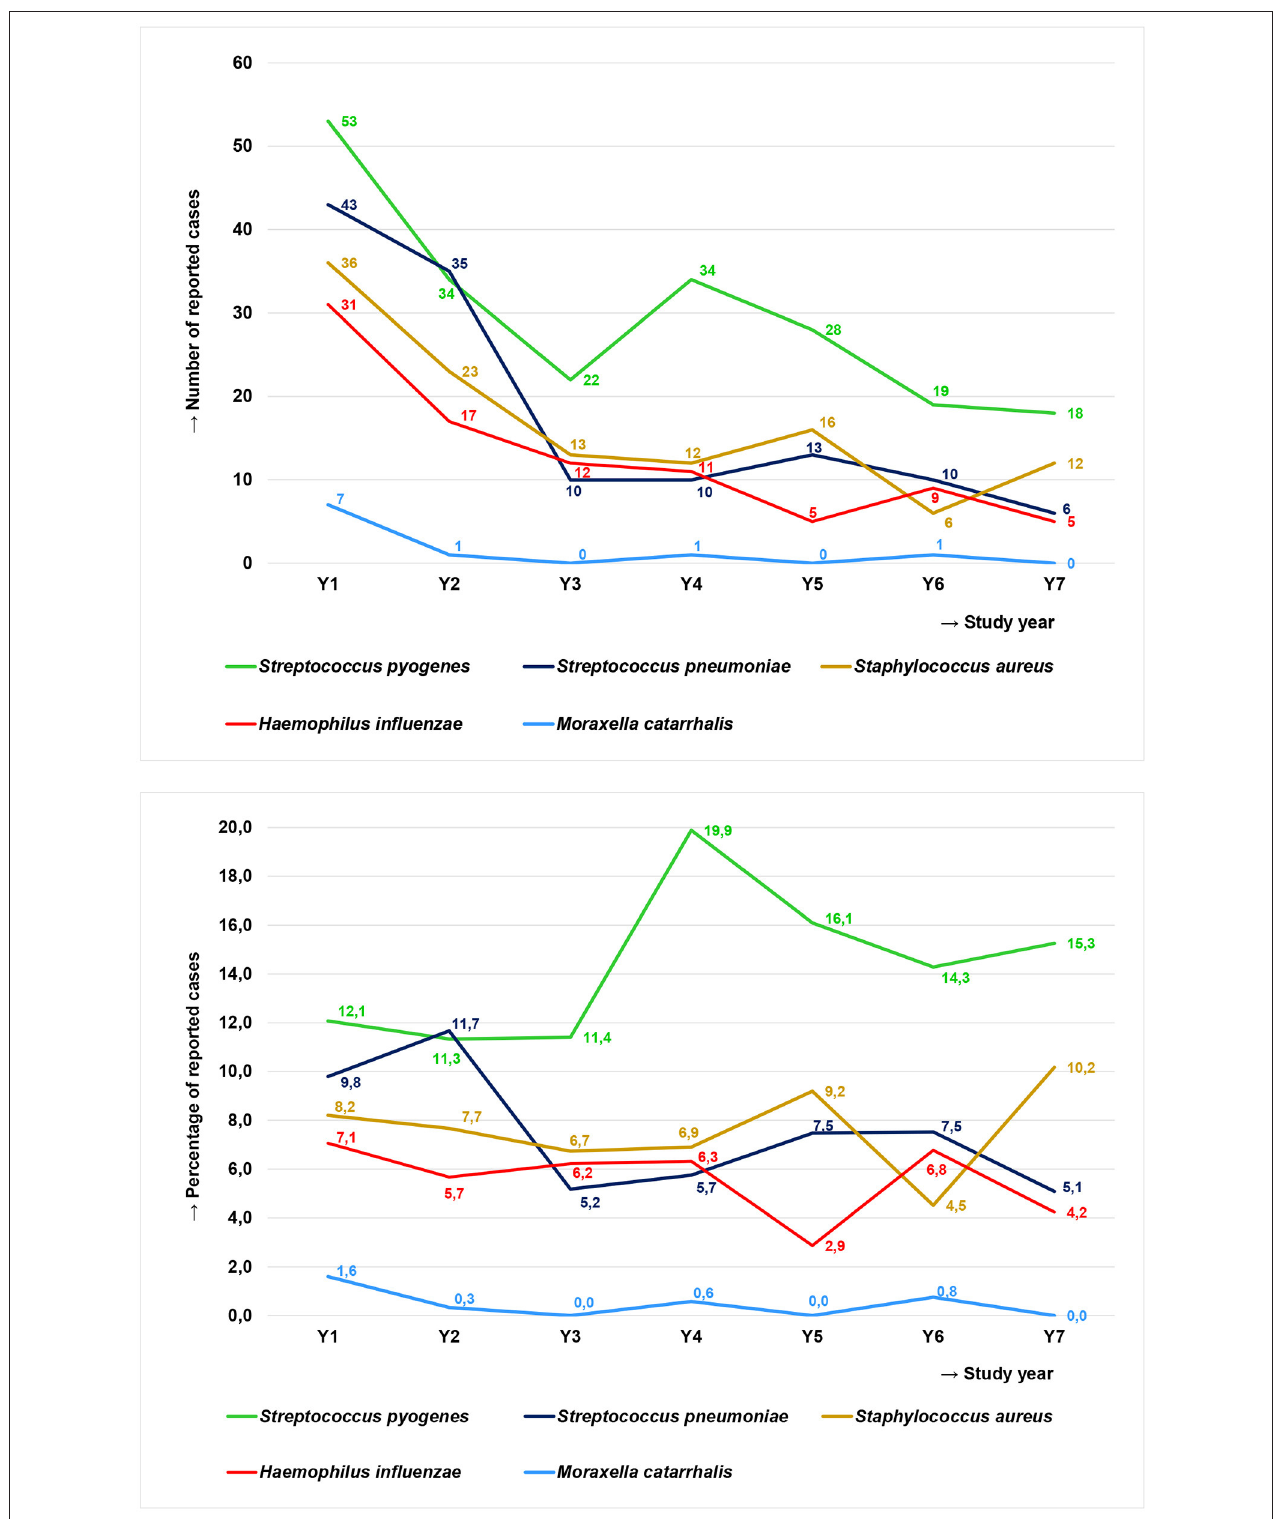
FIGURE 3 | Relevant pathogens in MEF of children in Germany with severe spontaneously ruptured AOM over the seven study years reported from the initial 43 study centers depicted as reported case numbers (Top) and as the percentage of total reported cases (Bottom) .